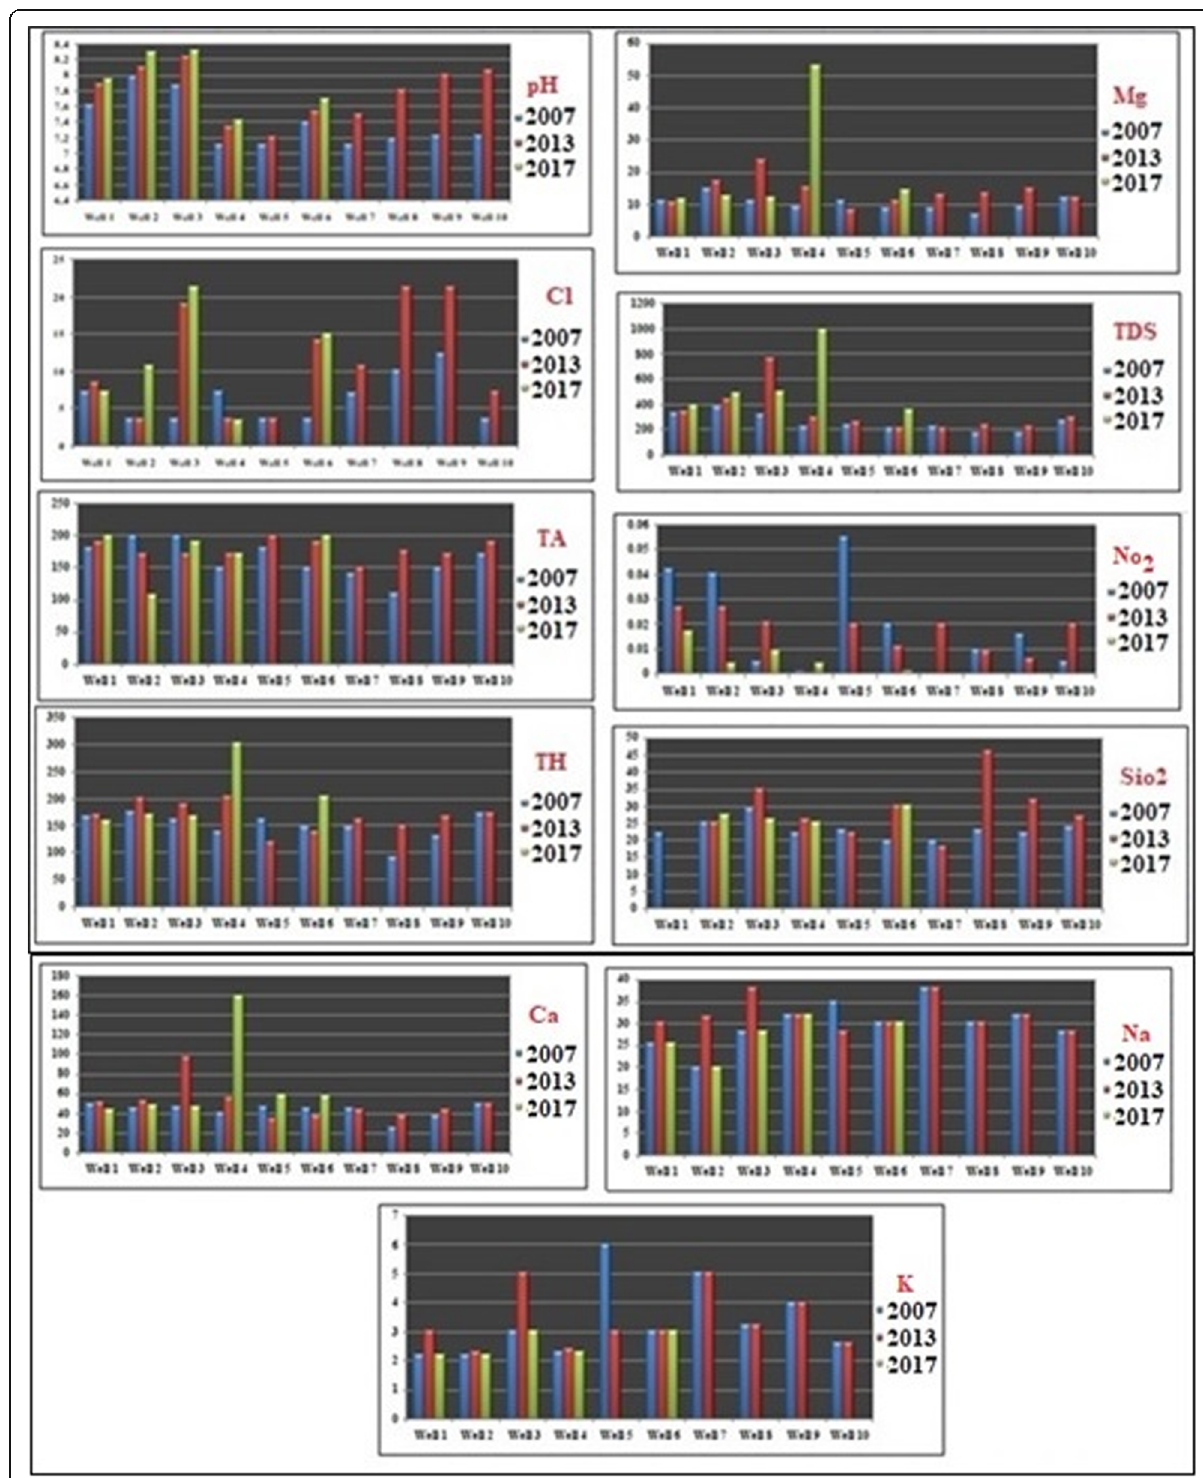
Fig. 5 Bar diagrams show the variations in the groundwater composition during the periods (1990 –